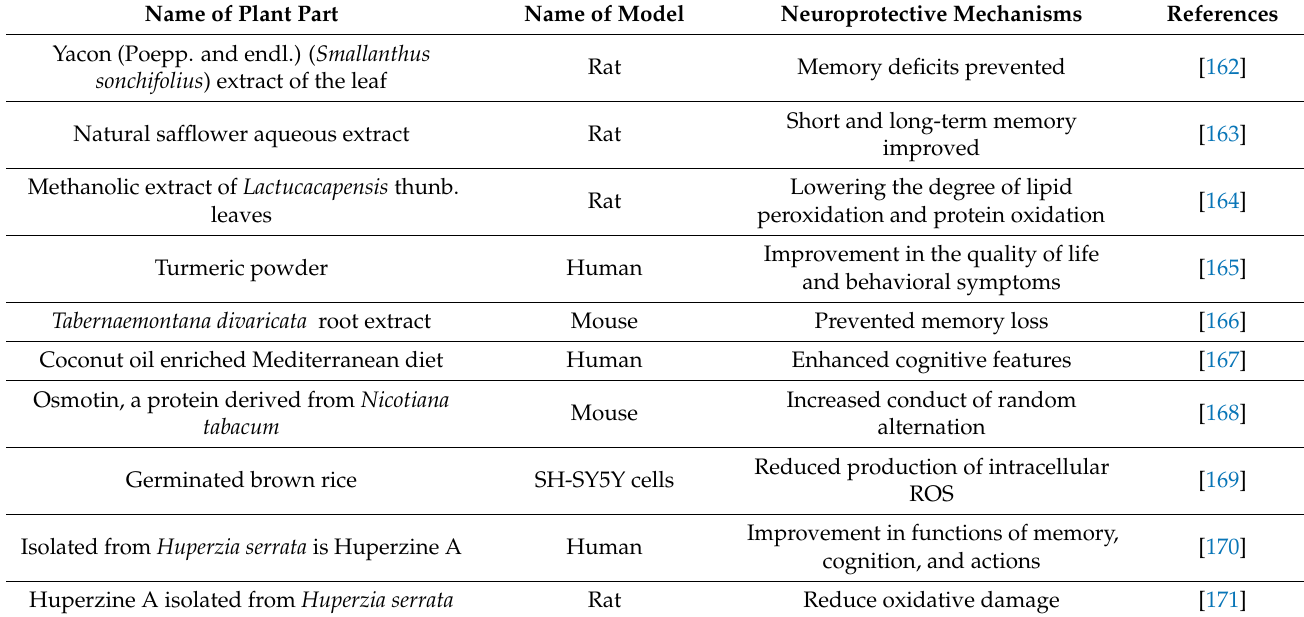
Table 1. Representative natural products and their bioactive substances with neuroprotective activity in the treatment of AD related disease model.